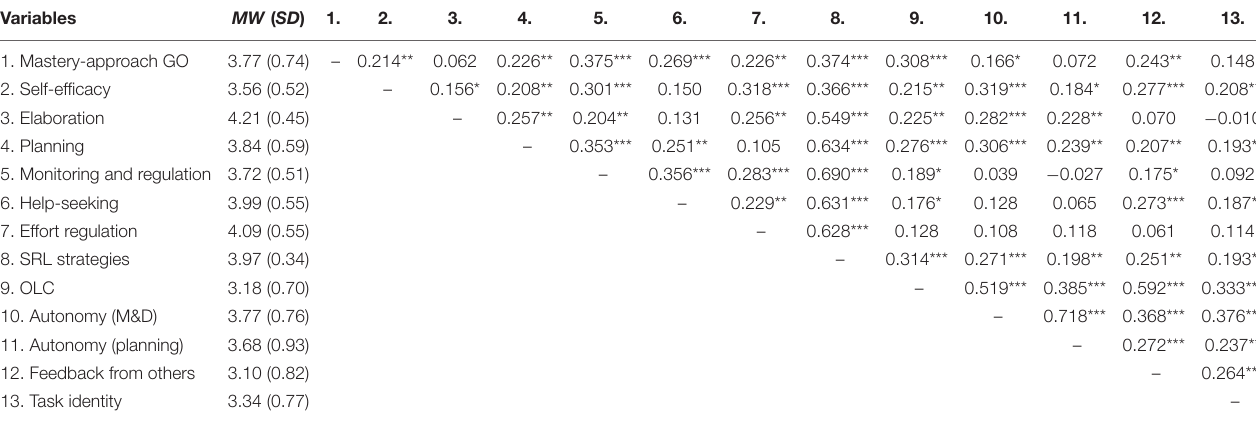
TABLE 2 | Means, standard deviations, and correlations between study variables. Variables